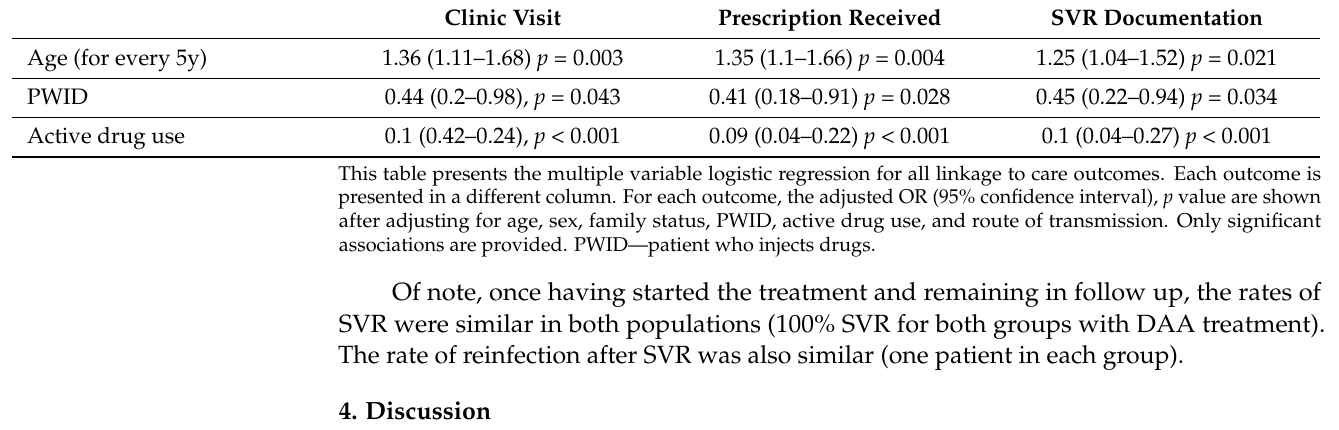
Table 4. Multivariate